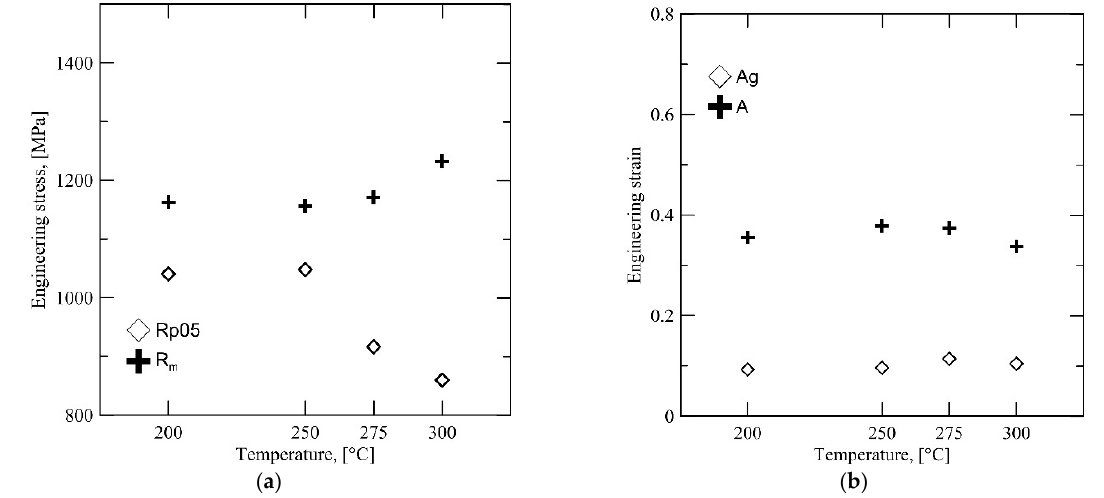
Figure 9. ( a ) The measured 0.5% proof strength and R m values for Steel B with respect to QT . ( b ) The uniform elongation Ag and total elongation A for Steel B with respect to QT . Specimens annealed at 850 °C, quenched to QT and partitioned at 450 °C for 100 s.